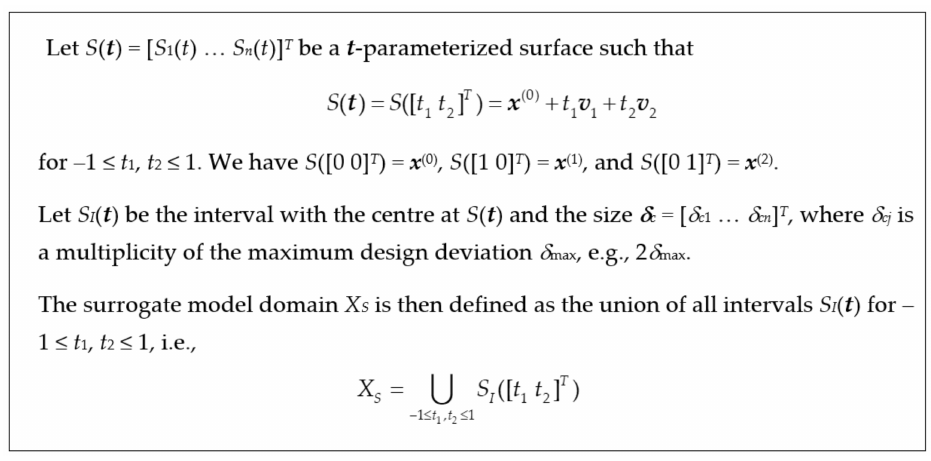
Figure 5. Surrogate domain definition using the reference designs. Microwave couplers case.